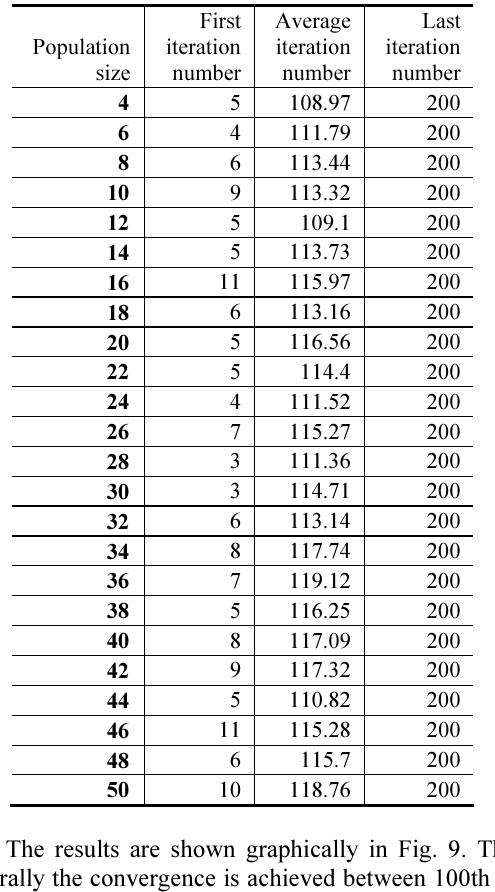
Table 3. Dependency of the convergence rate on the population size